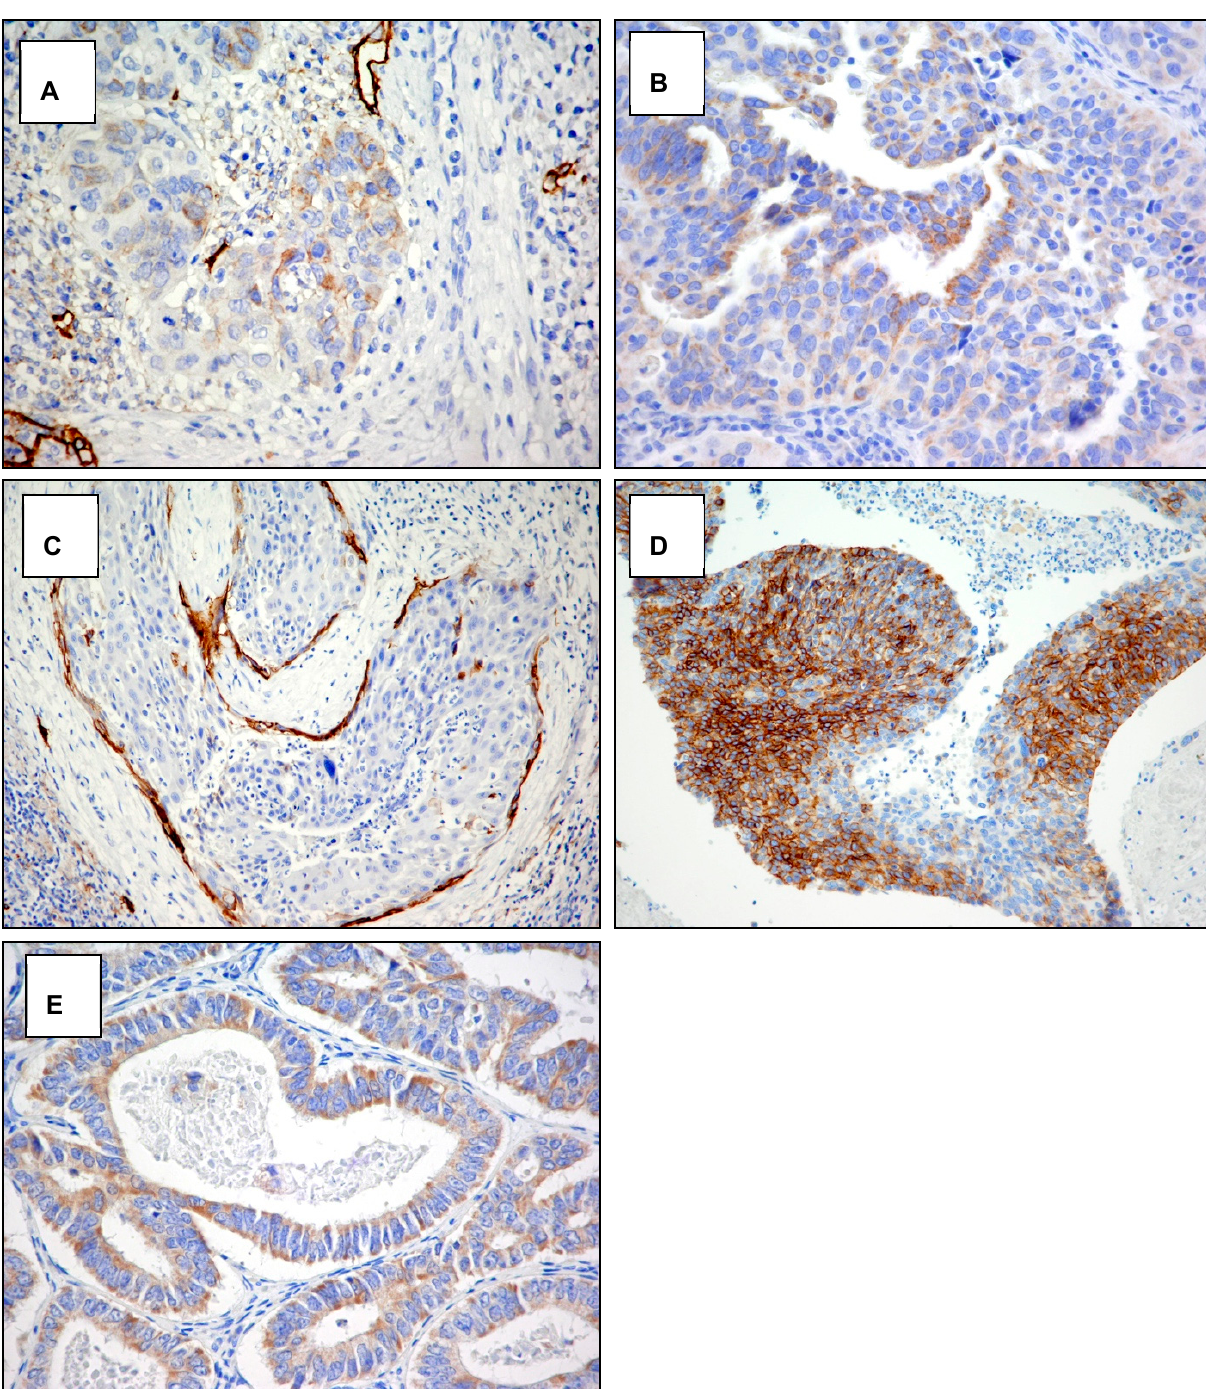
Figure A3. Cytoplasmic staining with D2-40 antibody. Examples of the pattern of podoplanin D2-40 antibody expression in squamous cell carcinoma and adenocarcinoma of the cervix. ( A ) Focal weakly staining in squamous carcinoma (score 1a) original magnification 400×. ( B ) Diffuse weakly staining in adenocarcinoma (score 1b) original magnification 400×. ( C ) Focal strong staining in squamous carcinoma (score 2a) original magnification 200×. ( D ) Diffuse strong staining in squamous carcinoma (score 2b) original magnification 200×. (E) Diffuse strong staining in adenocarcinoma (score 2b) original magnification 400×.